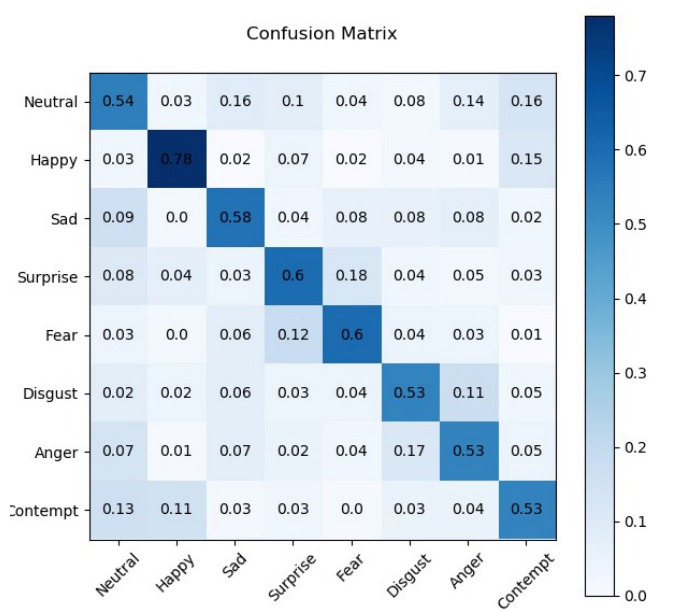
Figure 4. Facial expression classification confusion matrix of the proposed network architecture on AffectNet validation set.